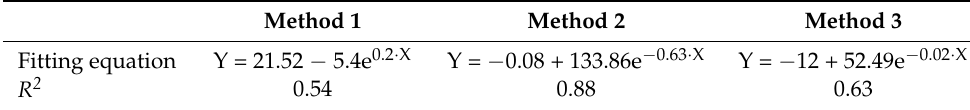
Table 1. Statistical table of dielectric constant–porosity fit data.